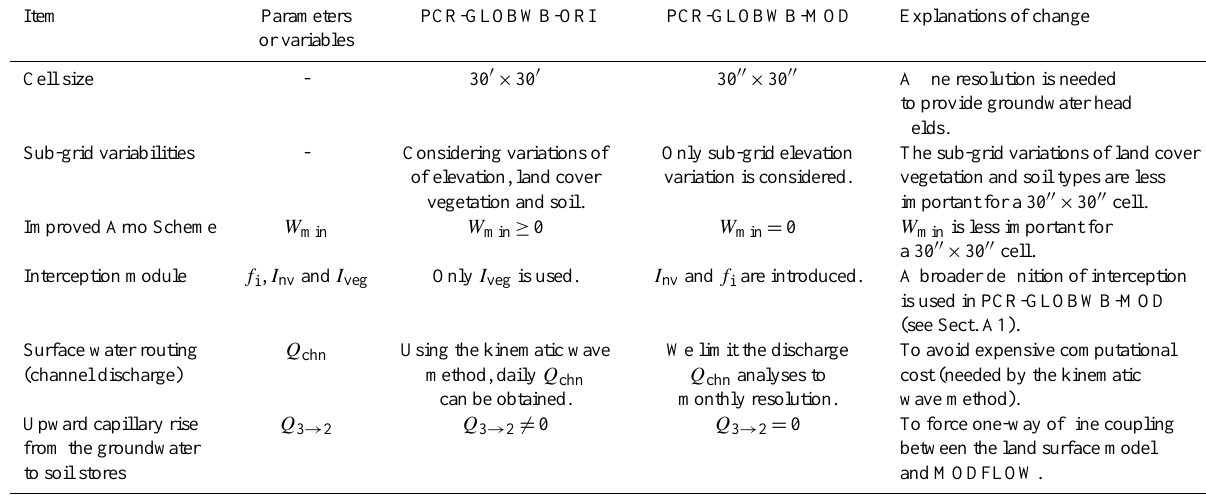
Table 3. Important changes in PCR-GLOBWB-MOD (compared to the original PCR-GLOBWB-ORI).